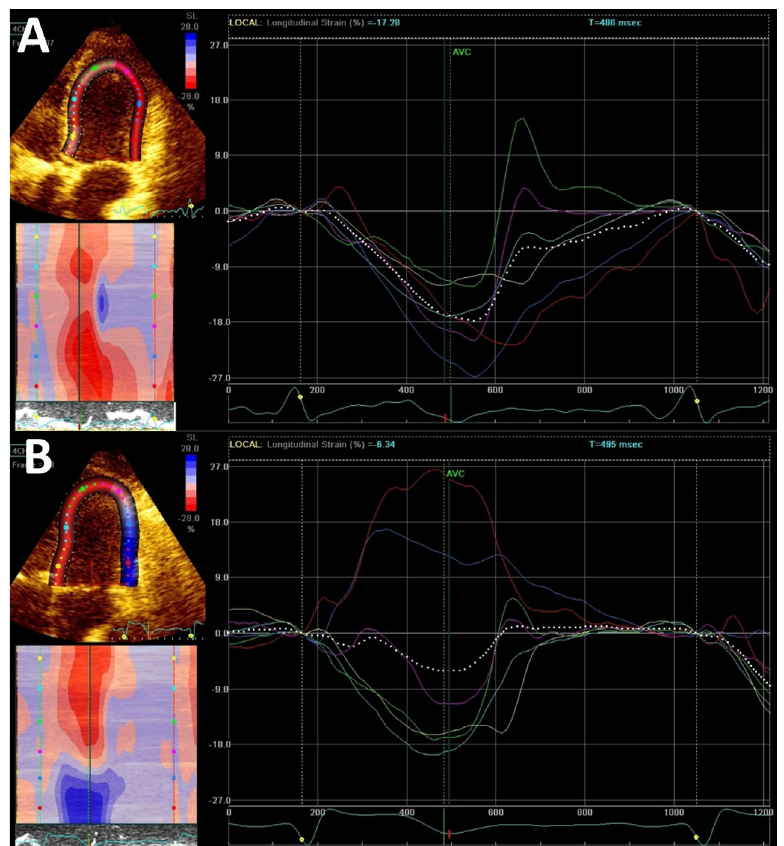
Fig. 3A. Speckle tracking derived longitudinal strain curve in heart transplant patient when free from rejection. The colored curves represent strains of individual segments and the white dotted line stands for global strain, i.e. mean for all segments. Fig. 3B. Shows the same patient as in figure 3A, this time in rejection. Obvious decrease in absolute values of global systolic strain can be attributed to local dyssynchrony in lateral segments in this patient. Nevertheless, no regularity was observed in the rejection strain